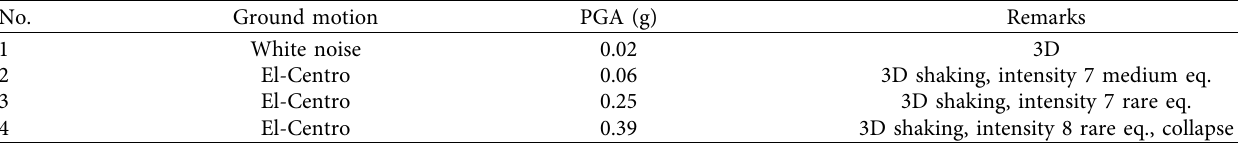
Table 6: Shaking table test protocol for the collapse of RC frame structure with infilled wall.